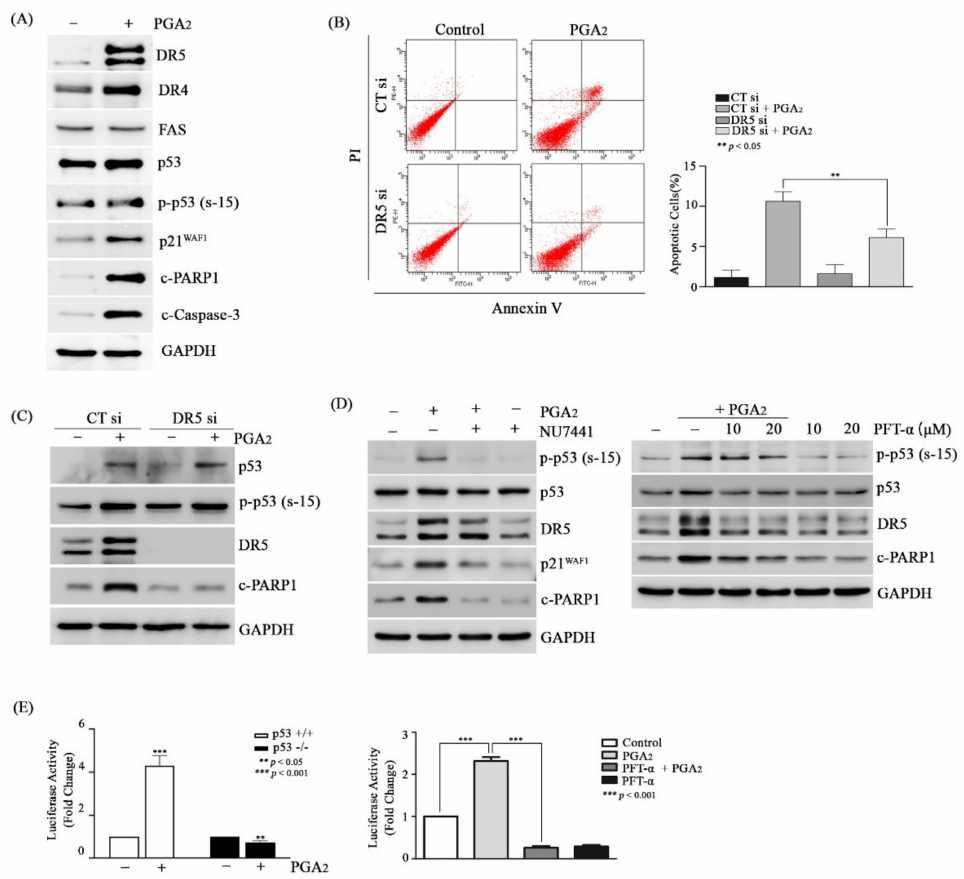
Figure 4. The e ff ect of DR5 on PGA 2 -induced apoptosis in HCT116 cells. ( A ) HCT116 cells were treated with PGA 2 (15 µ g / mL). After 18 h, WCLs were subjected to immunoblot analysis against indicated proteins using GAPDH as an internal reference protein. ( B ) HCT116 cells were transfected with scrambled RNA or siRNA targeting DR5 for 24 h and incubated in the presence of vehicle or PGA 2 (15 µ g / ml) for an additional 18 h. Cells were harvested and subjected to annexin V assay. The representative images (left) and statistical analysis (right) of three independent experiments were shown, respectively. The result of three independent annexin V assay was presented as mean ± SEM. ( C ) WCLs of HCT116 cells treated the same as described in ( B ) were subjected to immunoblot analysis against indicated proteins using GAPDH as an internal reference protein. ( D ) HCT116 cells treated with Nu-7441 (left) or PFT- α (right) for 1 h were incubated in the presence of vehicle or PGA 2 (15 µ g / ml) for another 18 h. WCLs were subjected to immunoblot analysis against indicated proteins using GADPH as an internal reference protein. ( E ) (left) After DR5 promoter-luciferase construct (pGL3-DR5) was transfected into HCT116 cells and HCT116 p53- / - cells along with renilla luciferase for 24 h, HCT116 cells were treated with vehicle or PGA 2 (15 µ g / mL). (right) After DR5 promoter-luciferase construct (pGL3-DR5) was transfected into HCT116 cells along with renilla luciferase for 24 h, HCT116 cells were treated with vehicle or PFT- α (20 µ M) for 1 h and were incubated in the absence or presence of PGA 2 (15 µ g / mL). At 18 h post-treatment of PGA 2 , firefly luciferase activity of DR5 promoter was measured by Dual luciferase assay method using renilla luciferase activity as the